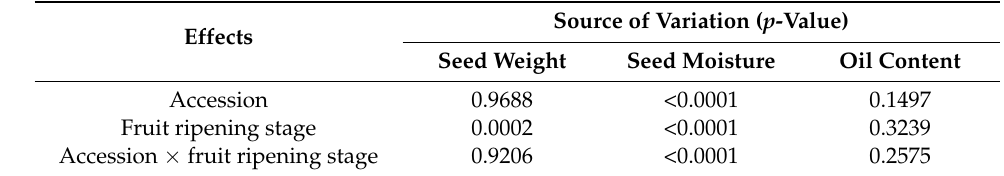
Table 2. Significance ( p -value) of effects from jatropha accessions and fruit ripening stage on seed dry weight, moisture content, and oil content in a jatropha plantation at Portoviejo, Ecuador.